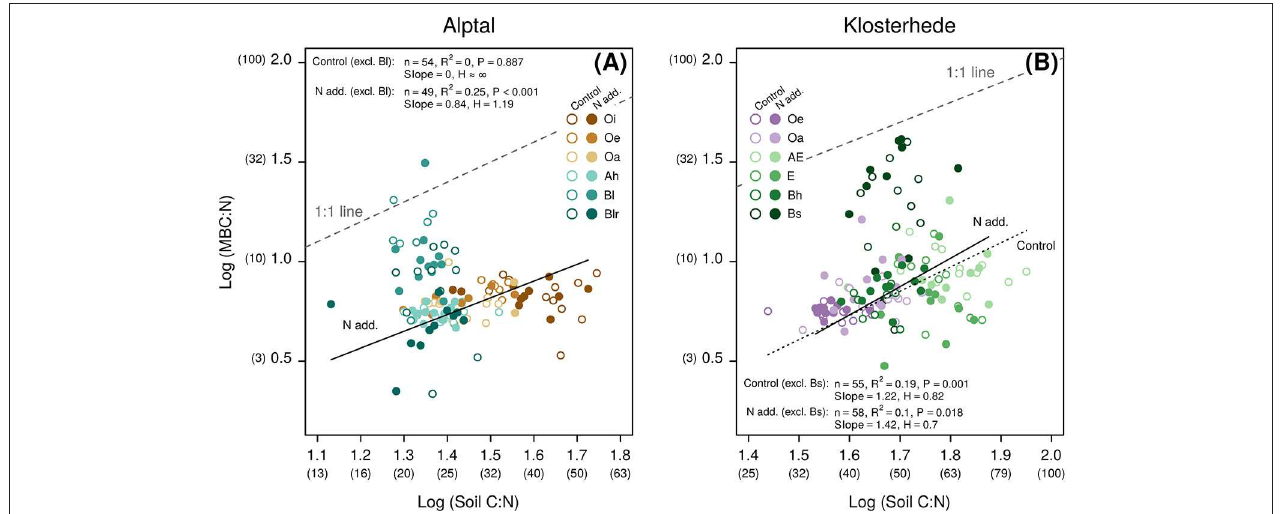
FIGURE 6 | Nitrogen addition alters microbial C:N homeostasis across the topsoil profile (0–30cm) at Alptal (A) and Klosterhede (B) . Degrees of C:N homeostasis were assessed by comparing of slopes from reduced major axis (Type II) regressions (see section Material and Methods for details). Non-transformed values of microbial C:N and soil C:N are given in parentheses below axes labels. Note that samples from Bl and Bs horizons were excluded from analyses. The strength of microbial homeostasis is given by the slope of the log-log relationship of between elemental ratios in resources (x-axes) and consumers (y-axes): Smaller slopes (S) indicate stronger homeostasis and the corresponding regulatory coefficient (H) is larger. Conversely, non-homeostatic relationships are indicated by larger slopes, i.e., smaller regulatory coefficients.